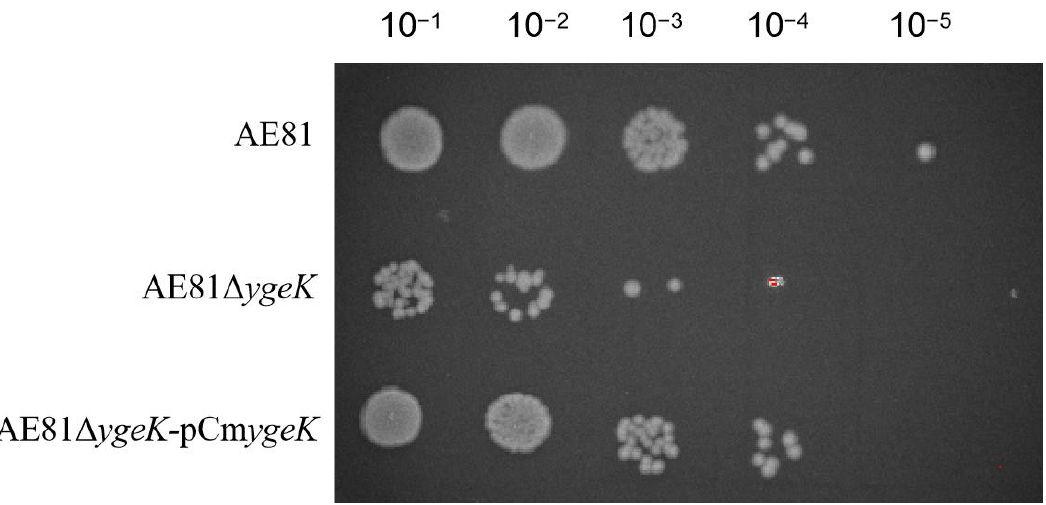
Figure 3. Hydrogen peroxide sensitivity in AE81, AE81Δ ygeK , and AE81Δ ygeK- p CmygeKI strains.